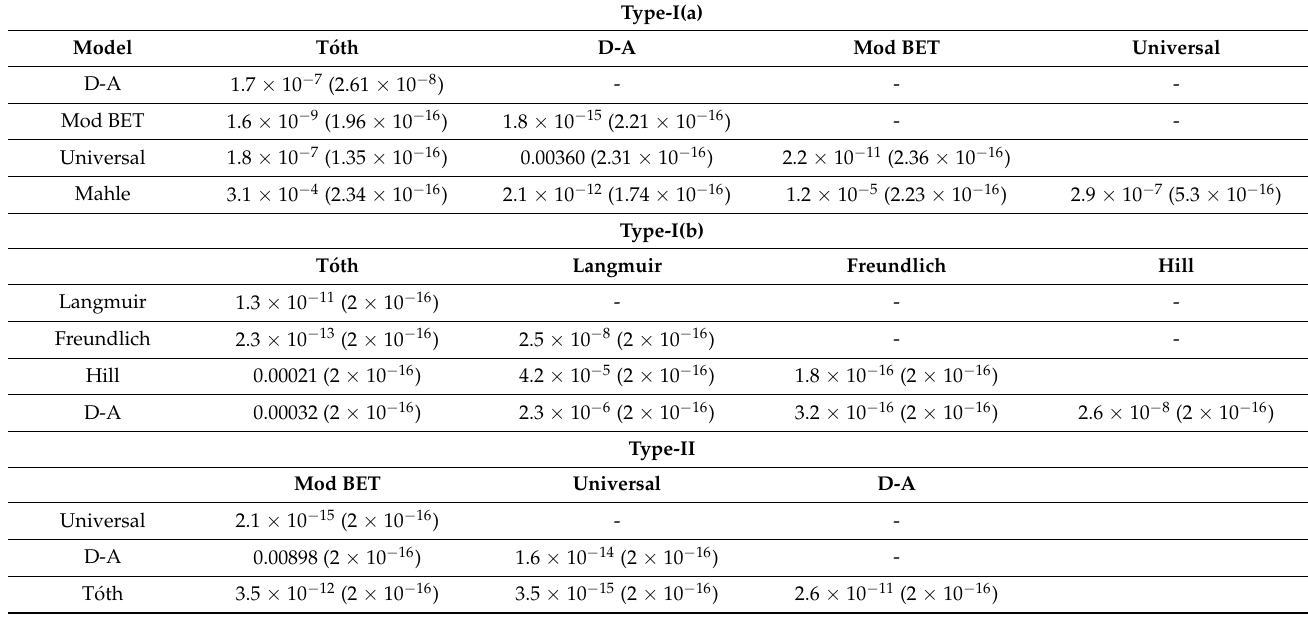
Table 5. p -value of pairwise test results. Without parenthesis Tukey HSD and within parenthesis Wilcoxon rank-sum